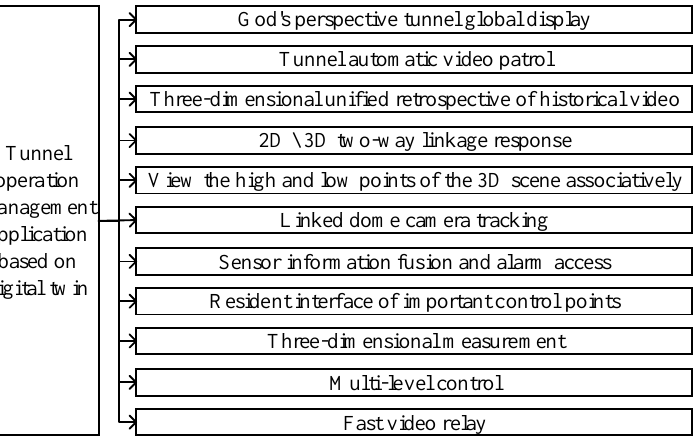
Figure 9. Application reference of tunnel digital twin operations management based on virtual-real fusion.